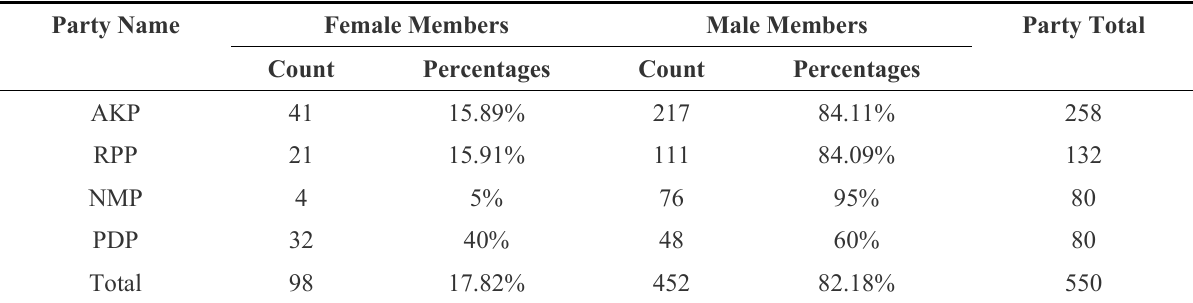
Table 1. GNAT deputy distribution by gender